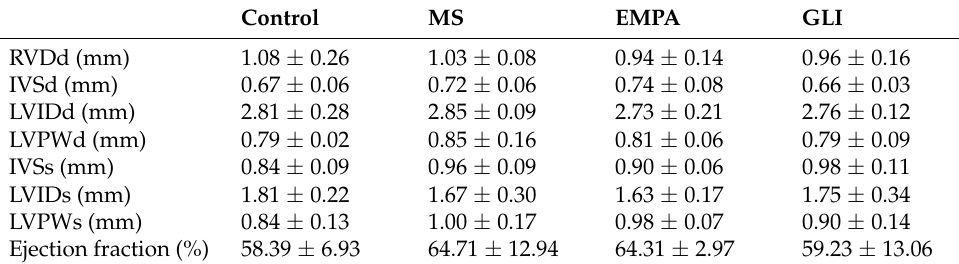
Table 2. Characteristics of echocardiography in the study